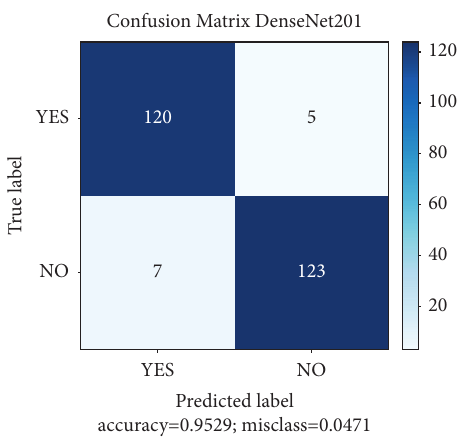
Figure 13: DenseNet201 network architecture accuracy based on F1-score.